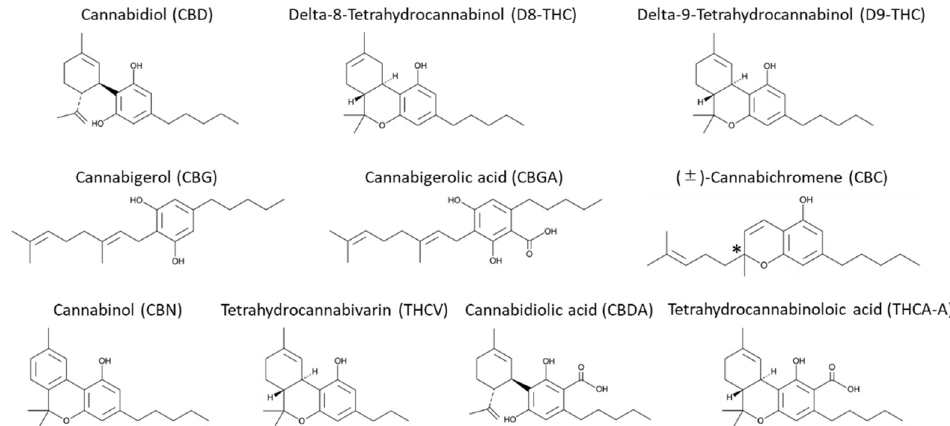
Figure 7. Structures of cannabinoids in 10-phytocannabinoid mixture.